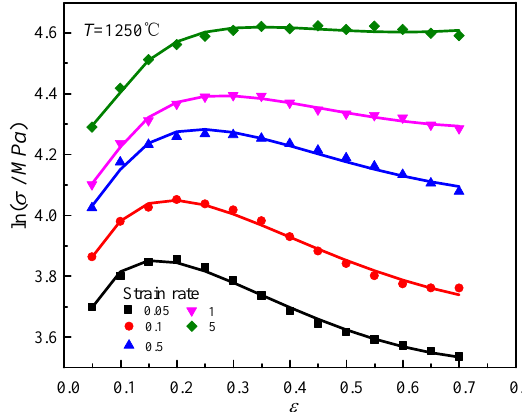
Figure 7. Relationships between ln σ and ε at 1250 ◦ C. Solving parameter A .